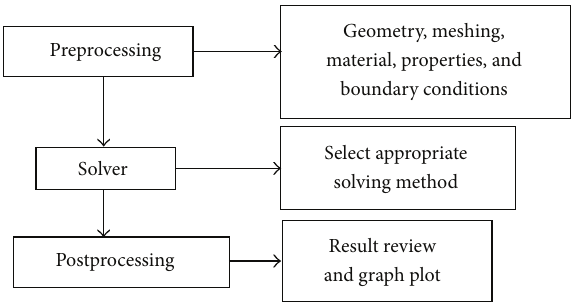
Figure 1: Typical FEA procedures by commercial